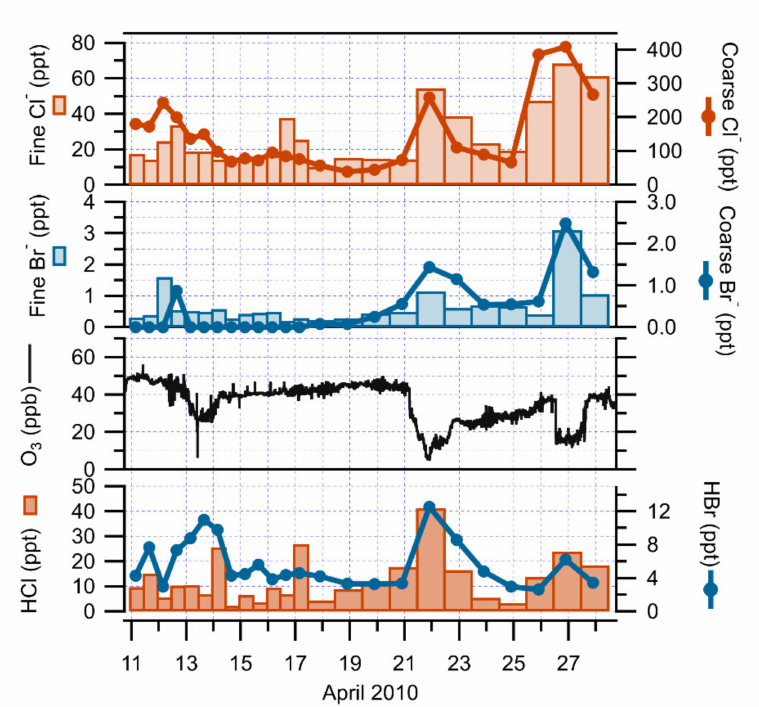
Figure 4. Time series of fine and coarse particulate Cl − , fine and coarse particulate Br − , HCl and HBr concentrations together with O 3 concentrations from 10 to 27 April 2010 at